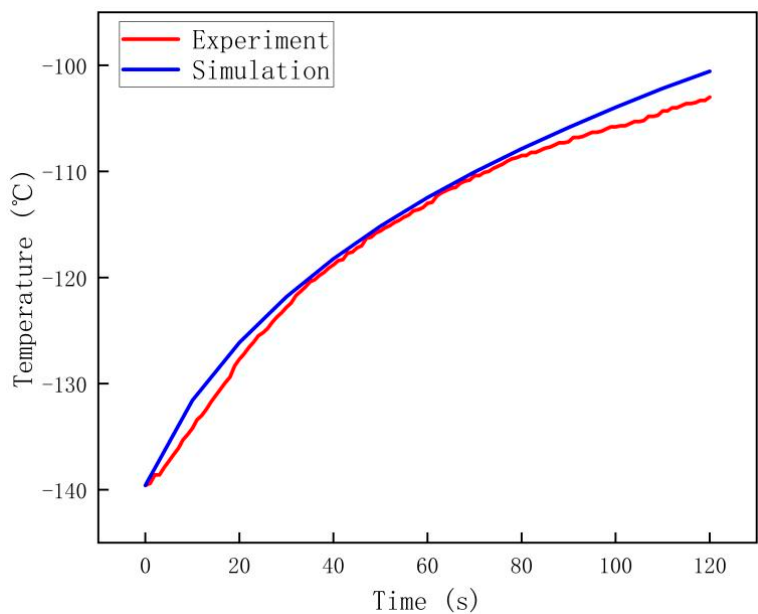
Figure 9. Drill bit temperature curve for No. A1 in experiment and simulation.